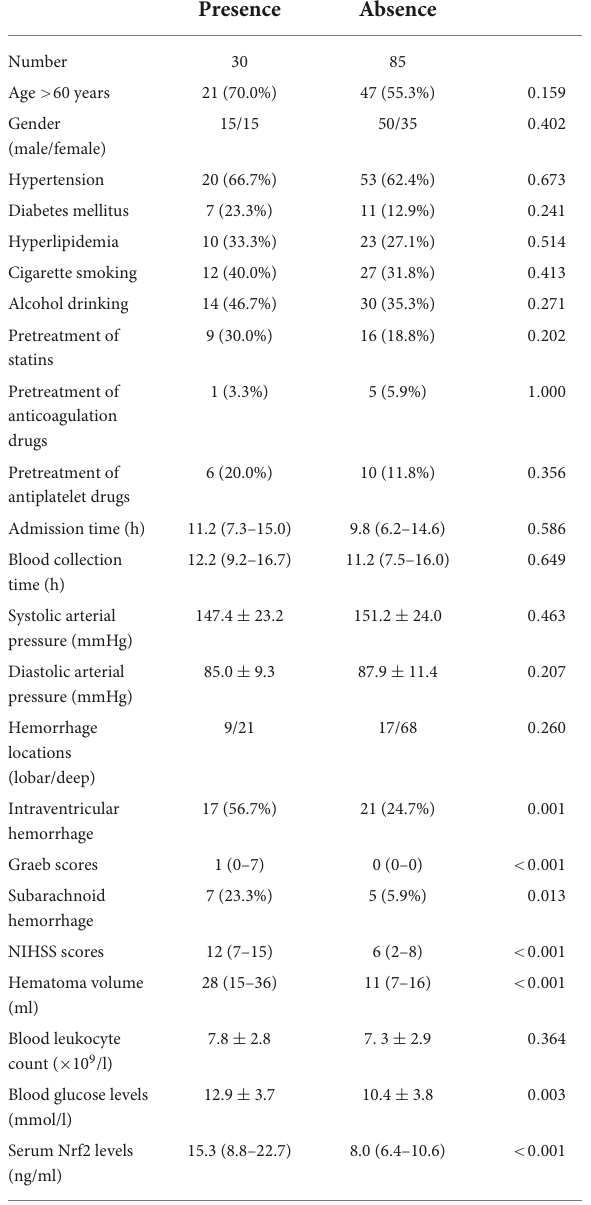
TABLE 3 Factors associated with early neurologic deterioration (END) after acute intracerebral hemorrhage (ICH).